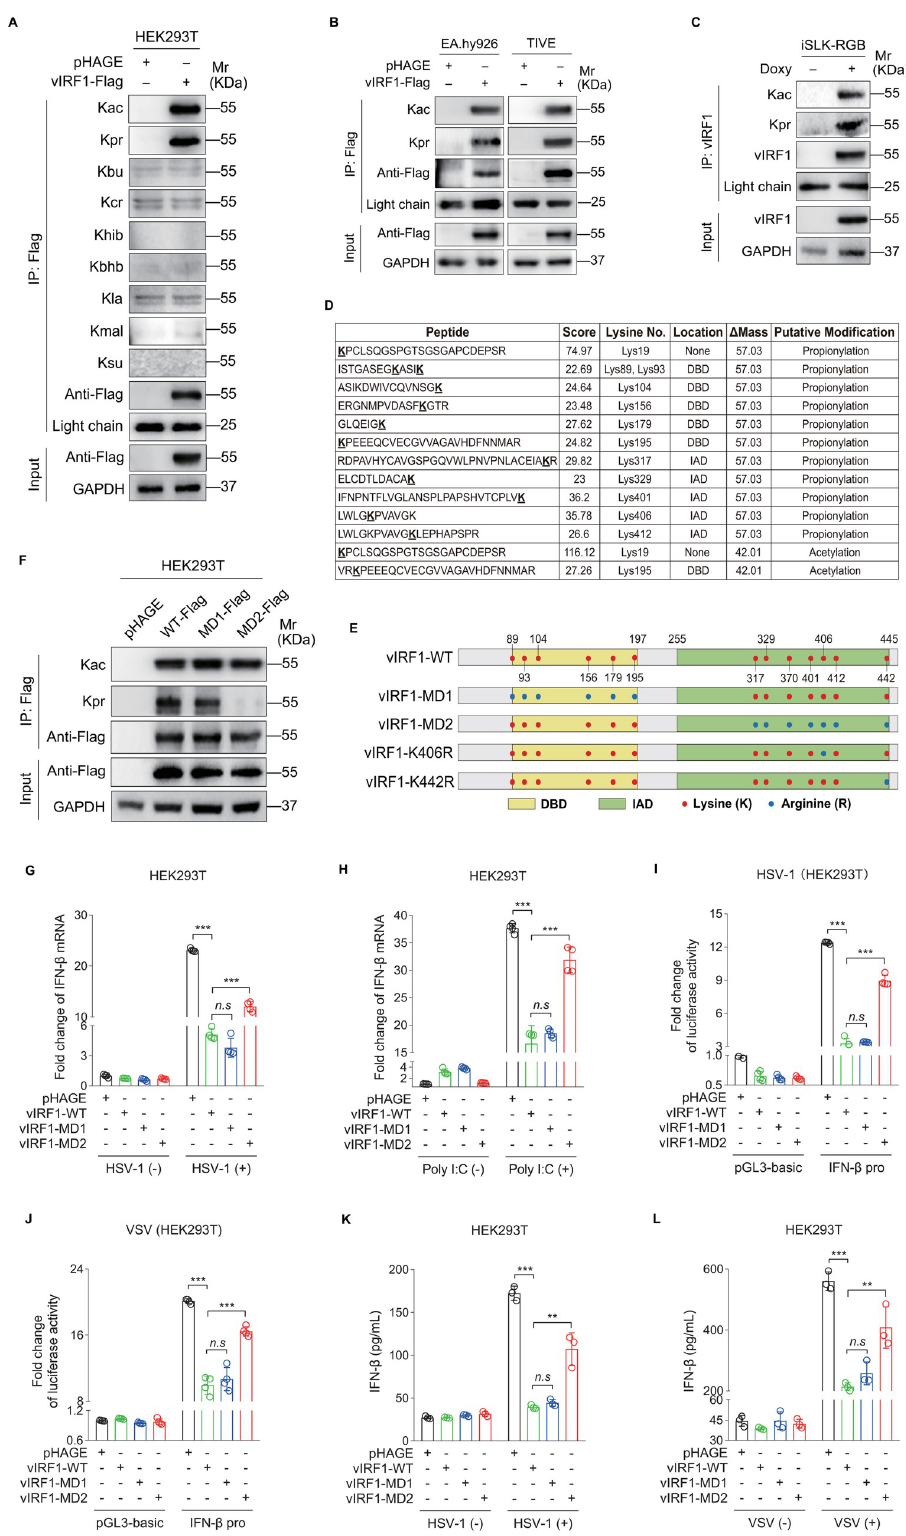
Fig 1. vIRF1 is propionylated by lysine to repress IFN- β production. (A). HEK293T cells were transduced with lentiviral vIRF1 ( vIRF1-Flag ) or control lentivirus ( pHAGE ), and then subjected to anti-Flag